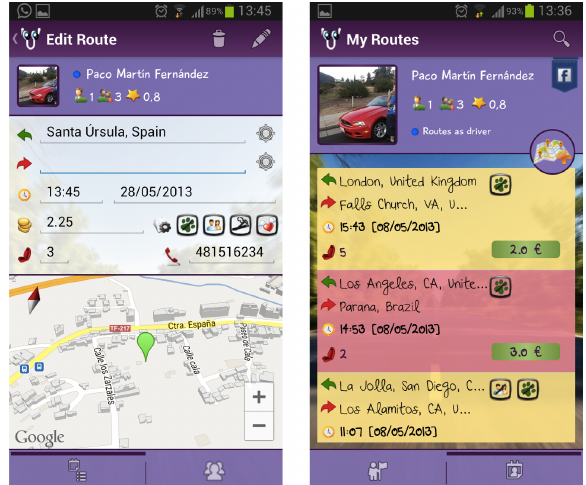
Figure 4. Carpoolap Screens: Route Edition and Routes List.